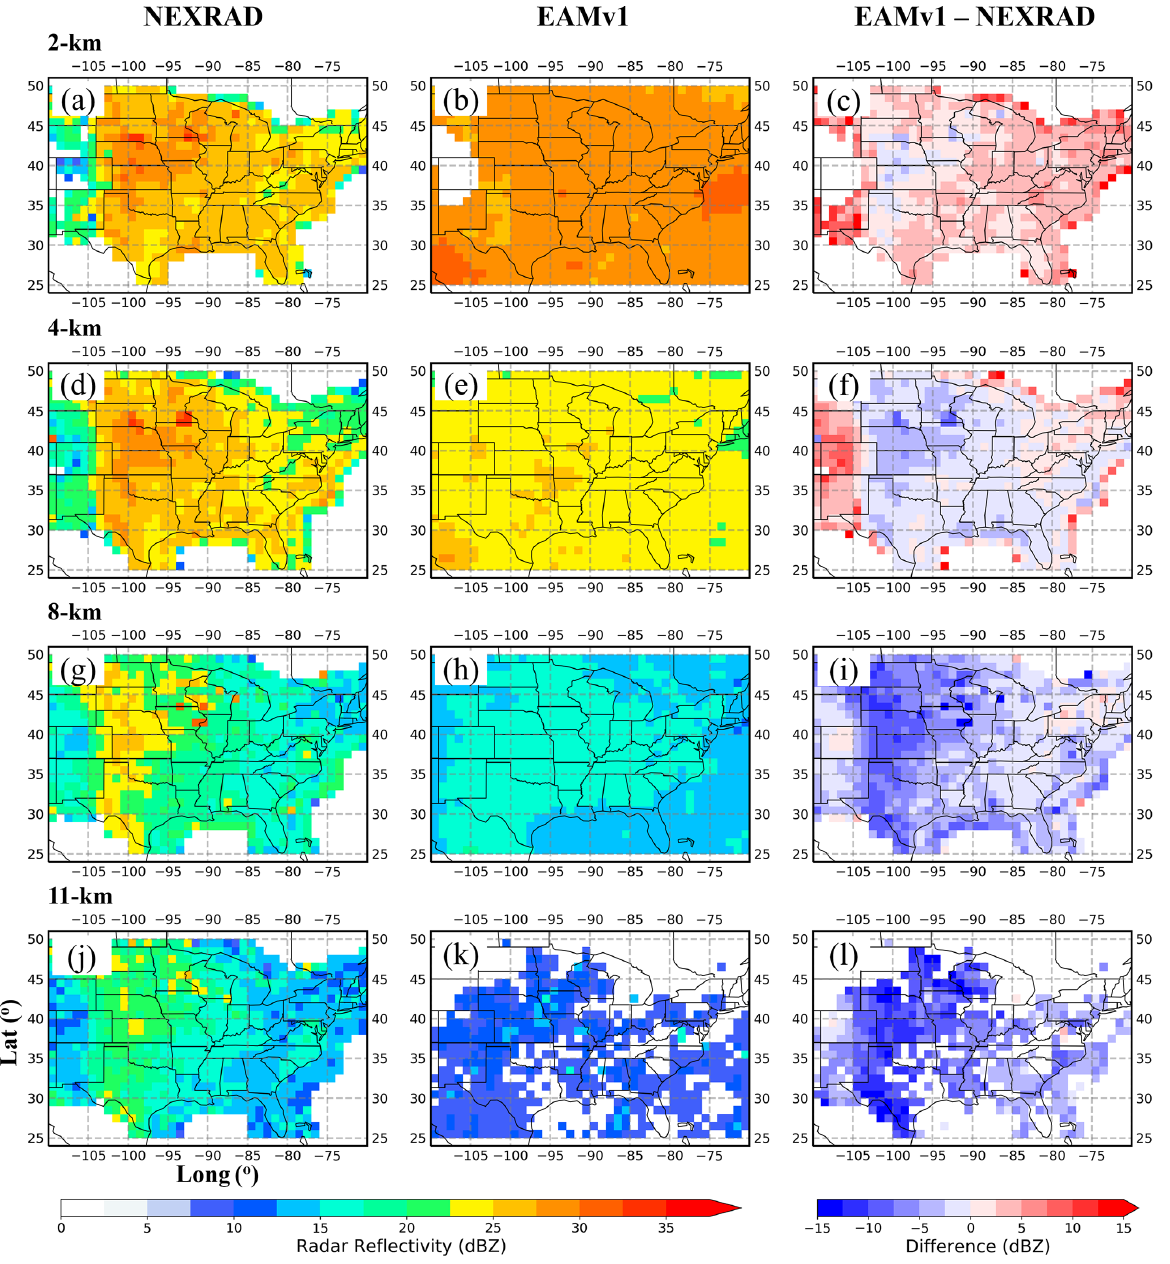
Figure 5. Plan view of radar reflectivity averaged from NEXRAD observations (a, d, g, j) ; EAMv1 simulation with the modified microphysics assumptions in COSP (b, e, h, k) ; and their absolute differences (c, f, i, l) at the level of 2, 4, 8, and 11km altitude. The NEXRAD data are spatially averaged from native resolution to the model grid over the April–September period during 2014–2016, and the simulations are vertically interpolated to the NEXRAD